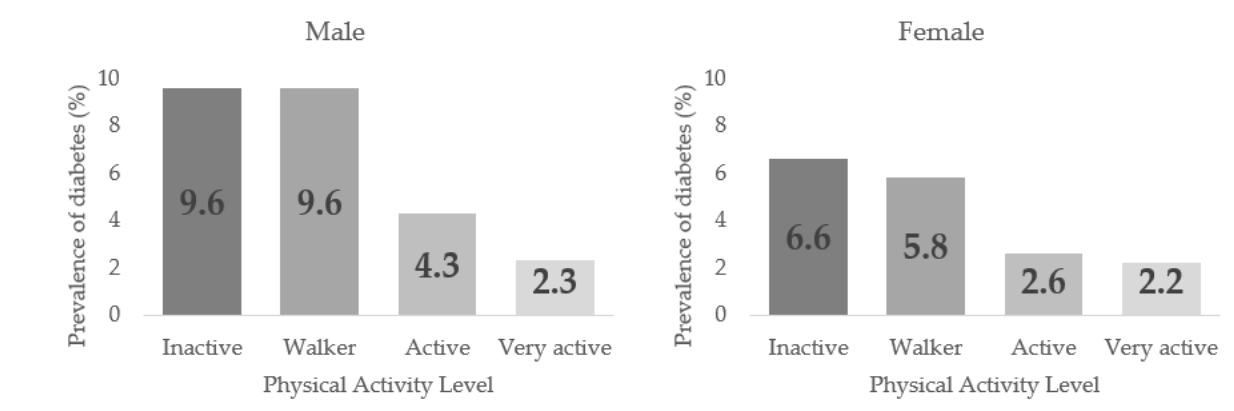
Figure 3. Diabetes Prevalence by Sex according to their Physical Activity Level (PAL). Table 4. Diabetes Medication Use prevalence by the Physical Activity Level (PAL) and Sex, Age and Body Mass Index